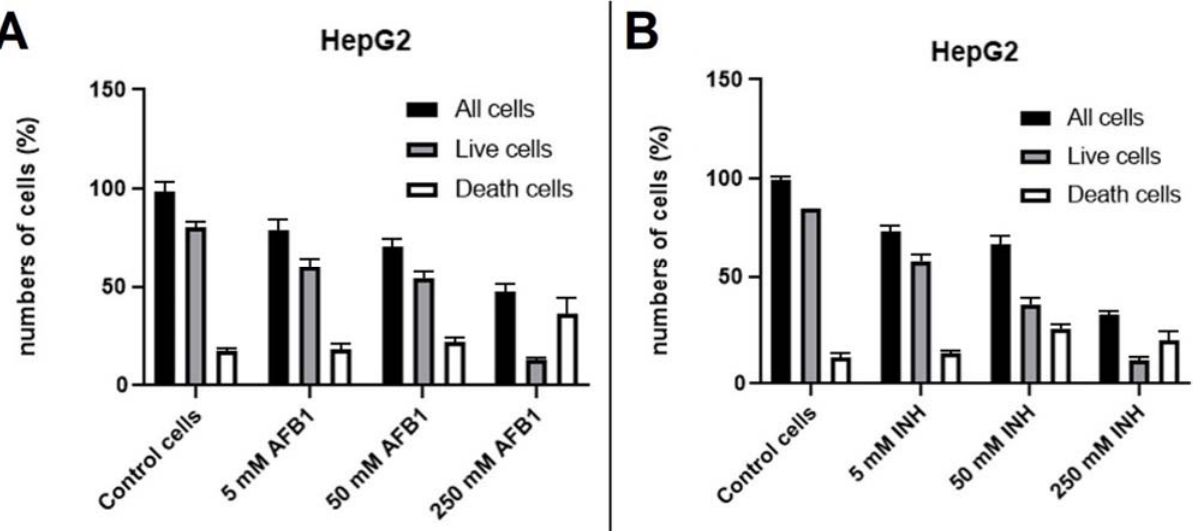
Figure 3. Impact of AFB1 and INH on HepG2 cell survival; graphs of the fluorescent microscopy of HepG2 cells exposed to AFB1 (0, 5, 50, and 250 μ M) ( A ) and INH (0, 5, 50, and 250 mM) ( B ) at 24 h using the double staining method with Hoechst 33342 and propidine iodide (PI).